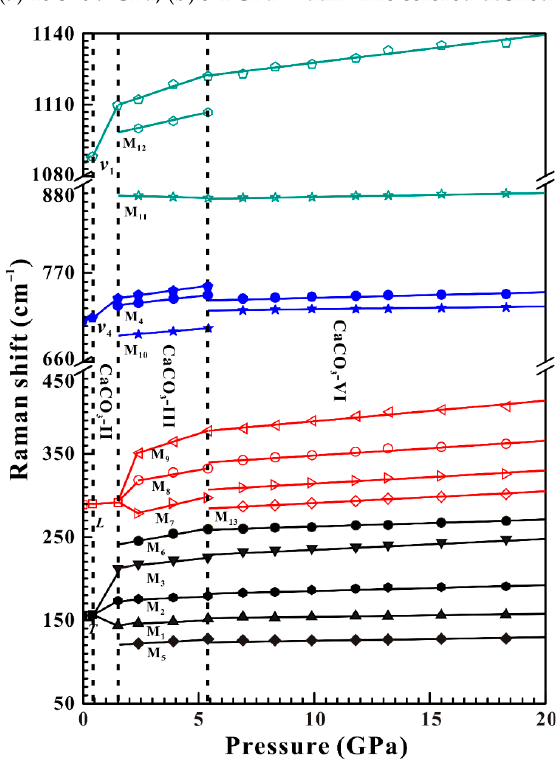
Figure 5. Pressure dependence of the Raman shifts of calcite upon decompression within the wavenumber range of 100–1200 cm − 1 at the atmospheric temperature. The colored solid lines and the vertical black dashed lines are used to guide the eyes.